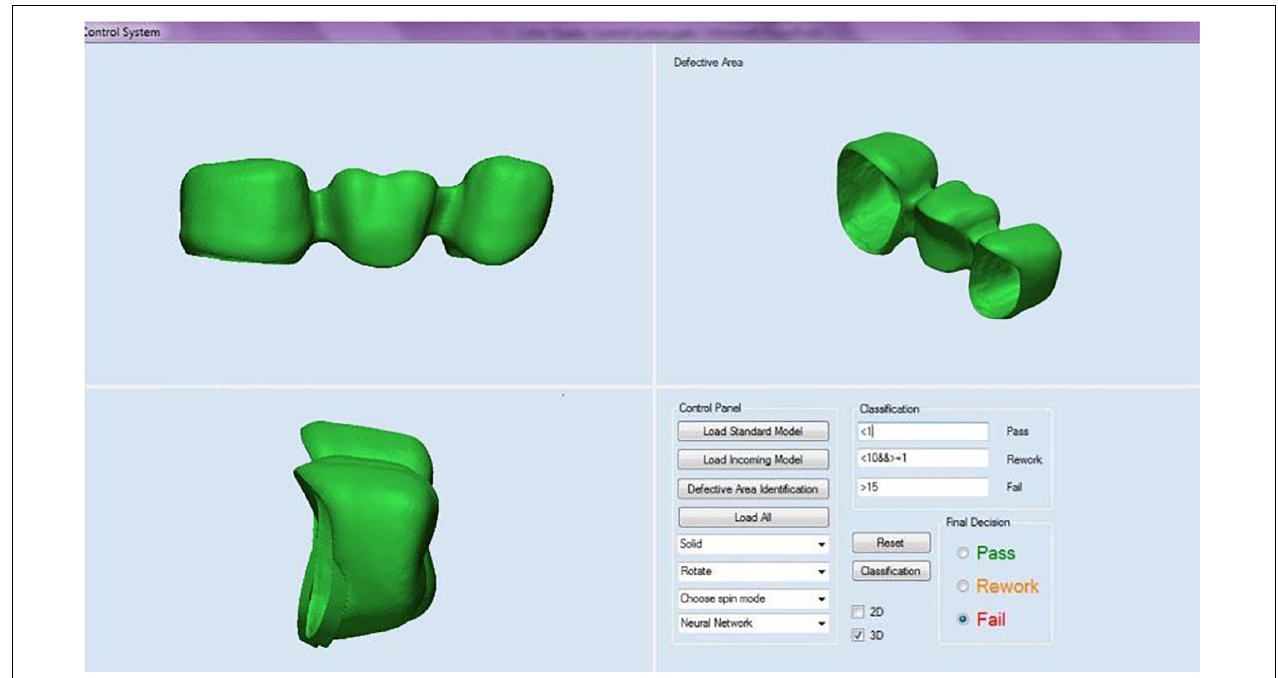
FIGURE 3 | 3D quality control API.